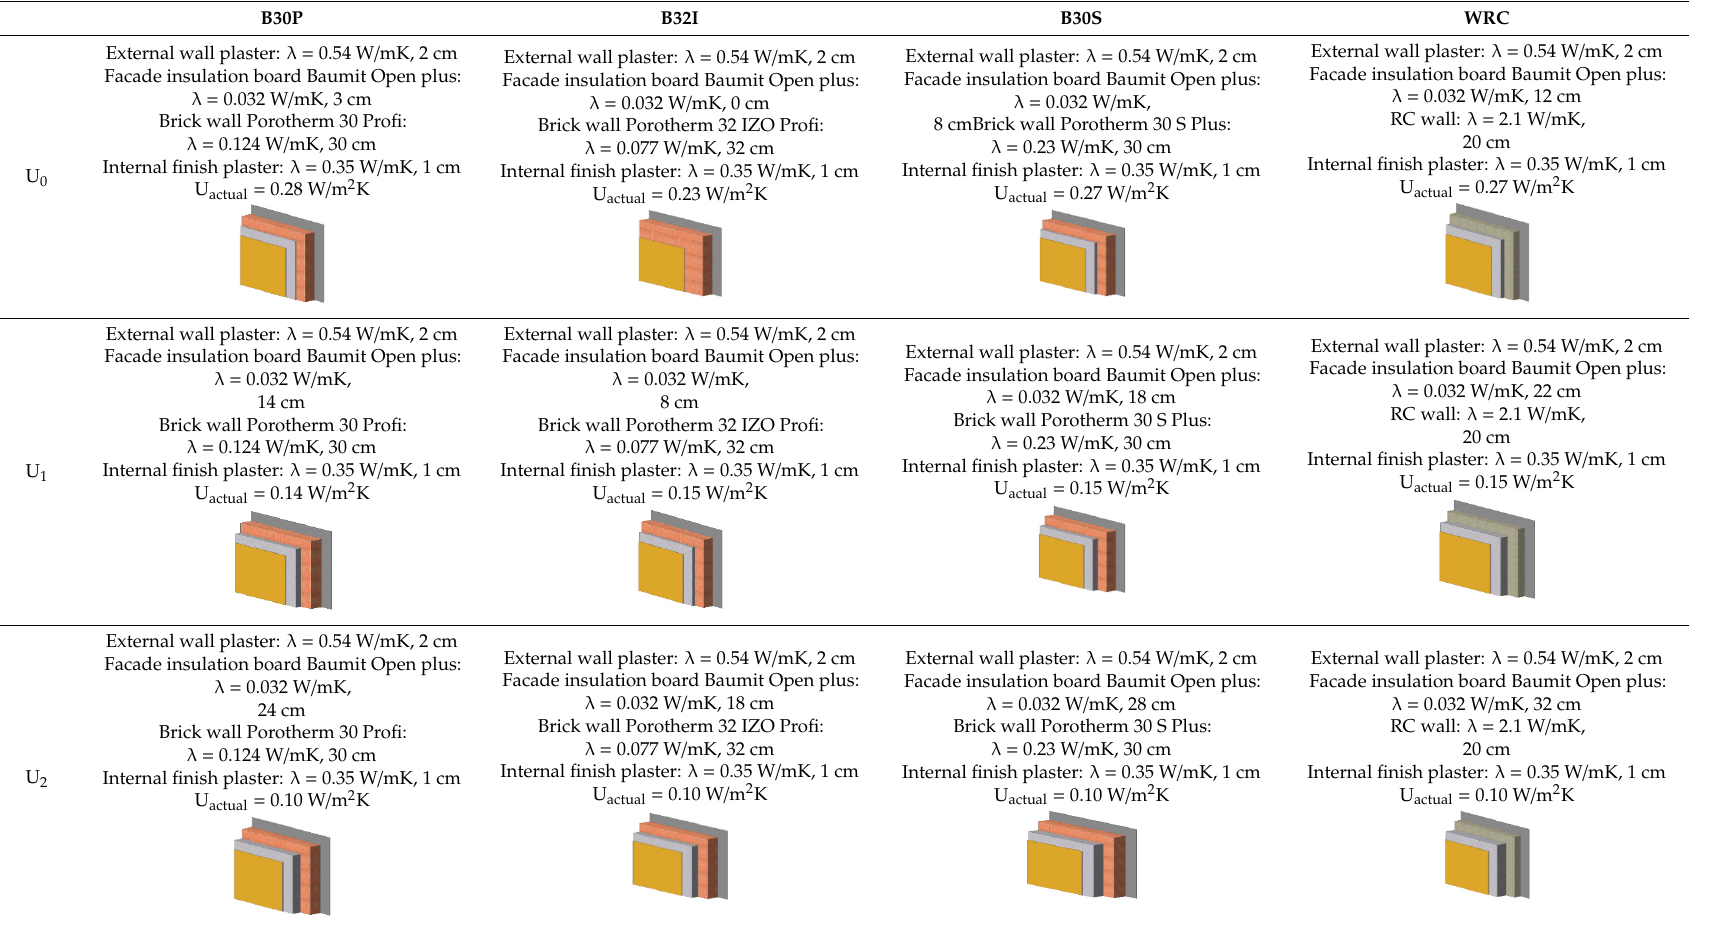
Table 1. The comparison of the analysed external wall components.